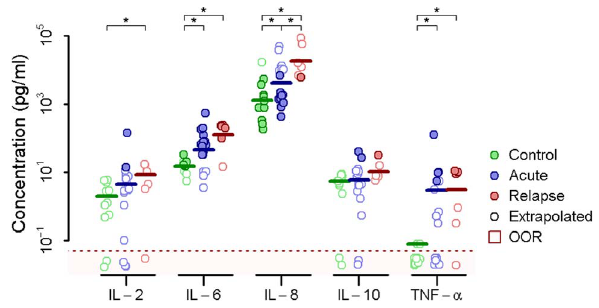
Figure 3. Basal PBMC cytokine secretion measured by multi- plex immunoassay. IL-2, IL-6, IL-8, IL-10, and TNF- a secretion in unstimulated PBMCs from control donors or acute or relapse brucellosis patients (asterisk indicates p # 0.05). Concentrations indicated by open circles were extrapolated beyond the assay standard curve and values in the red shaded zone fell outside the observable range (OOR).